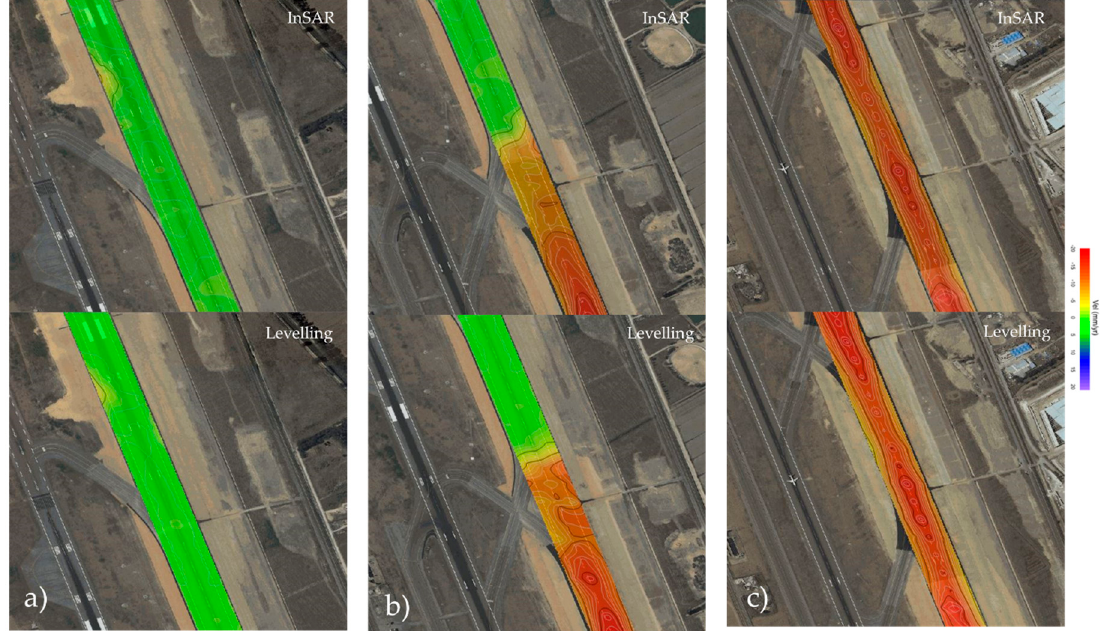
Figure 4. Comparison between the velocity maps obtained by (top) Persistent Scatterers Interferometry (PSI) datasets and (bottom) levelling, relative to ( a ) low (from 2600 m to 3200 m in N direction), ( b ) intermediate (from 1900 m to 2600 m in N direction), and ( c ) severe (from 850 m to 1620 m in N direction) displacing conditions .